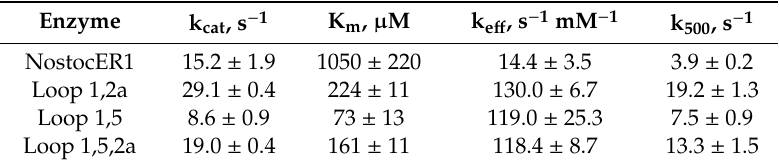
Table 1. Kinetic parameters of the NostocER1 wildtype and three NostocER1-variants with altered NADH-binding properties as published by Mähler et al. [12]. Listed are the catalytic constant (k cat ), Michaelis-Menten constant (K m ), and the resulting catalytic e ffi ciency (k e ff ) with NADH, as well as the specific activity using 500 µ M NADH (k 500